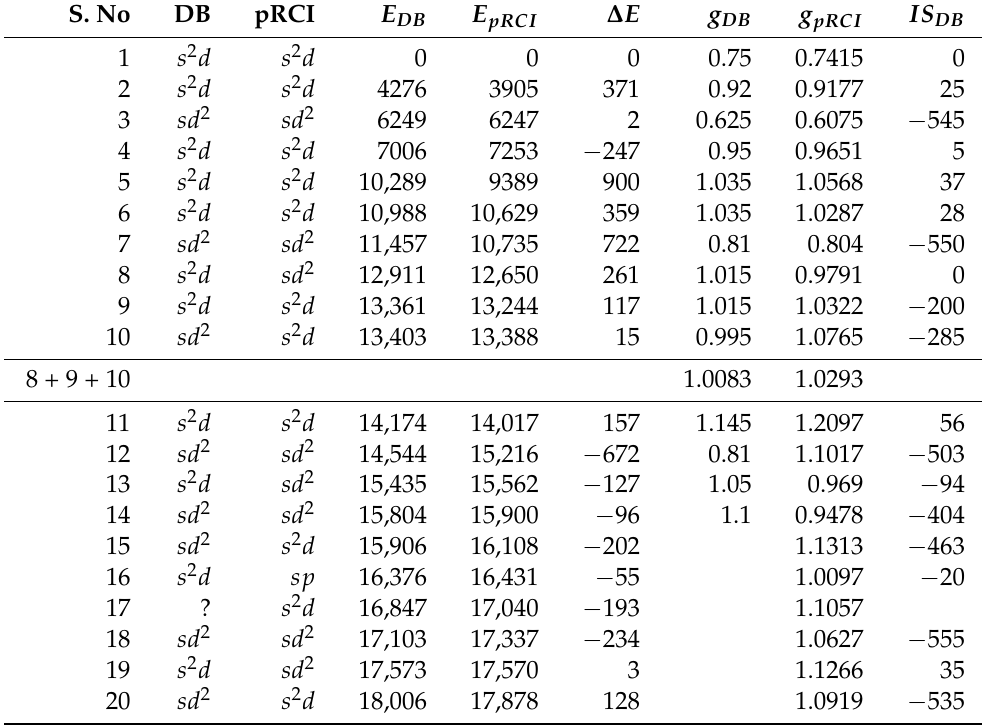
Table 2. Comparison of parametric RCI (pRCI) configurations, energies, and g -factors with ones given in database (DB) [13] for 20 J = 6 odd U I states. pRCI parameters are the following: